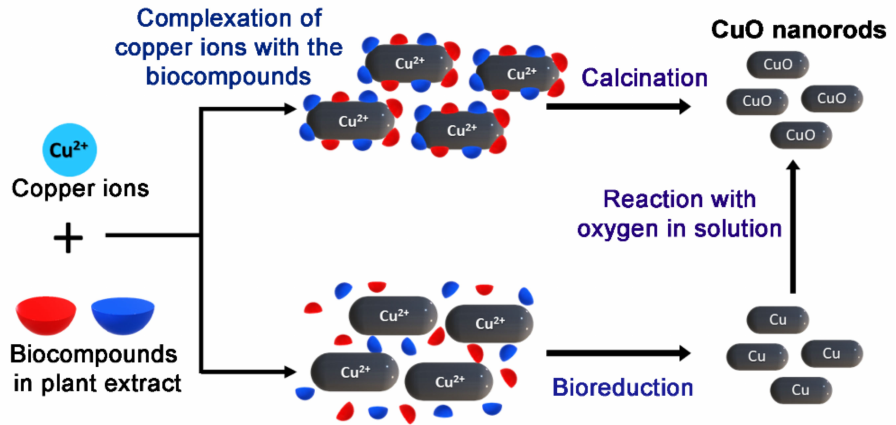
Figure 9. Possible reaction mechanism for M. calabura mediated CuO nanoparticles